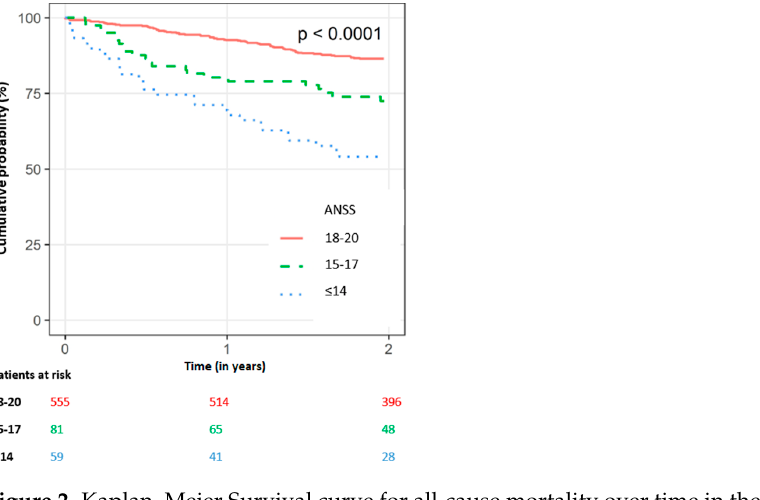
Figure 2. Kaplan–Meier Survival curve for all-cause mortality over time in the study population by admission Norton scale score. (Numbers reflect patients at risk. p value < 0.0001.) (ANSS, Admission Norton scale score).